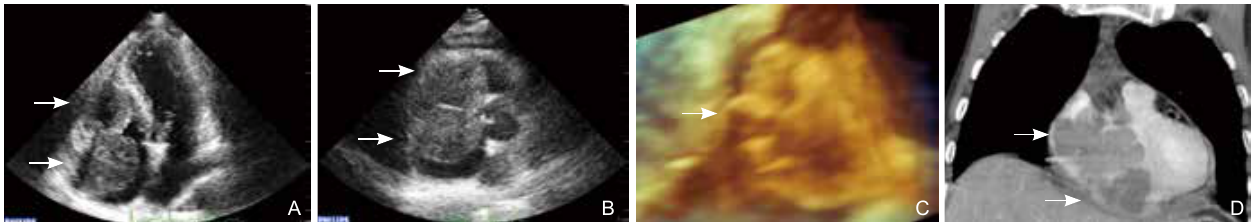
A B C Figure 1 Two- and Three-Dimensional Transthoracic echocardiography and thoracic CT-scan images show the tumor (arrows). Four-chamber view (A), short-axis view of the aortic (B), Zoomed 3D TTE image of the tumor (arrows) in RA as seen from atrial septal (C), and thoracic CT-scan images (D).